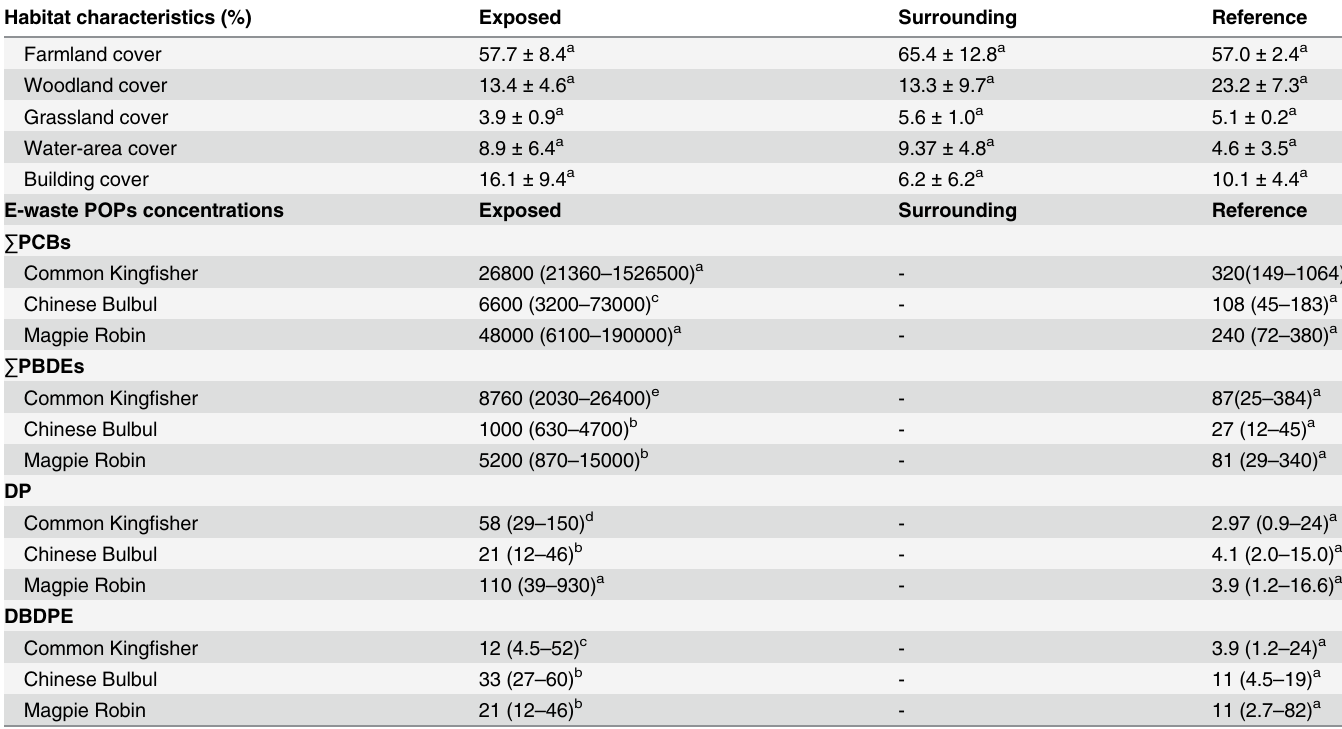
Table 1. Upper part: the major habitat characteristics where birds were censused for this